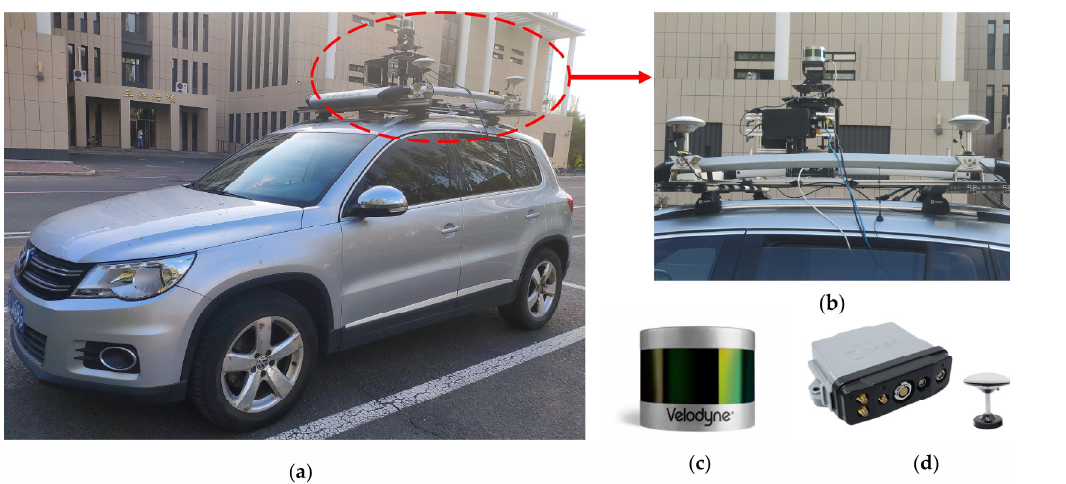
Figure 8. Sensors in this experiment. ( a ) The driverless vehicle platform (Volkswagen Tiguan) loaded with sensors; ( b ) arrangement of the vehicle-borne sensors; ( c ) LiDAR sensors surrounding Velodyne VLP-16E; ( d ) INS npos220s.